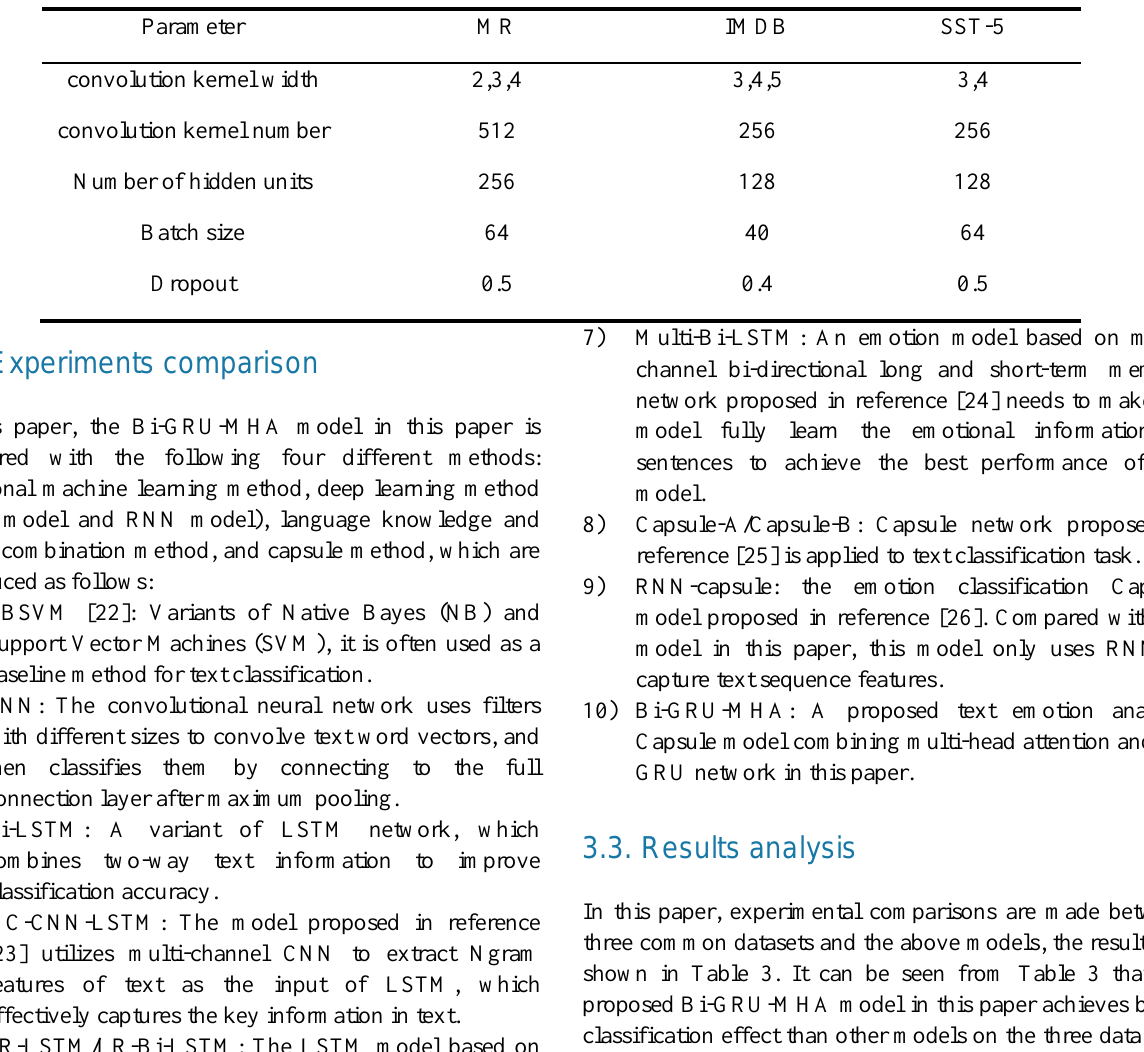
Table 2. Super-parameters of the